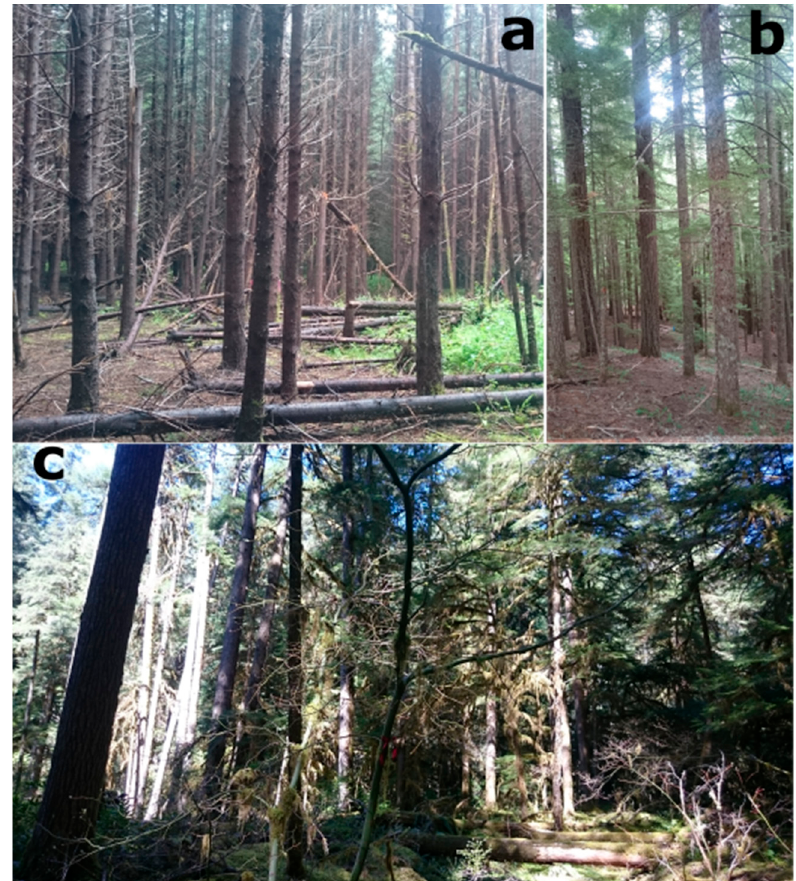
Figure 2. Inside a young ( a ), mature ( b ), and old-growth ( c ) stand from HJ Andrew.